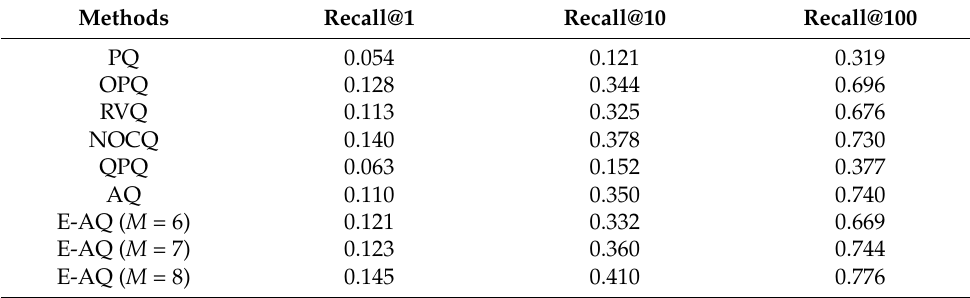
Table 3. Comparison of exhaustive ANN searches on